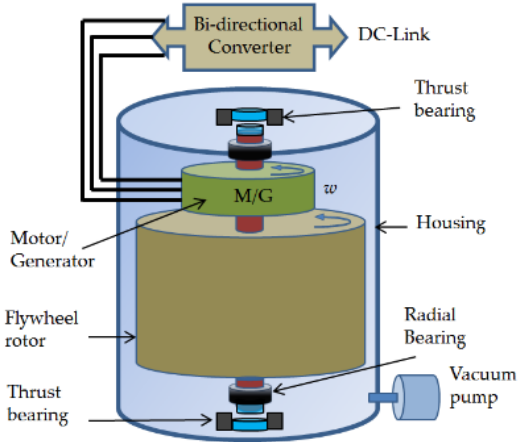
Figure 1. Structure and components of a flywheel.